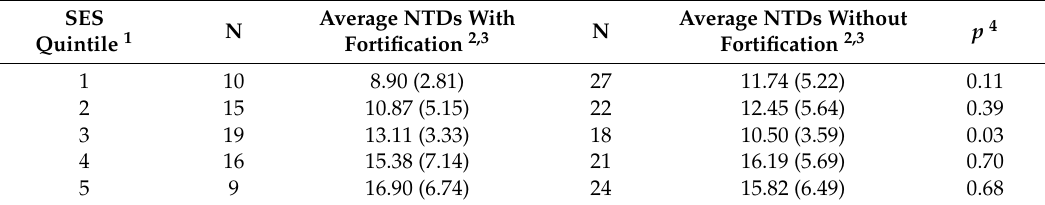
Table 3. Prevalence of NTDs as a function of socioeconomic status (SES) and folic acid